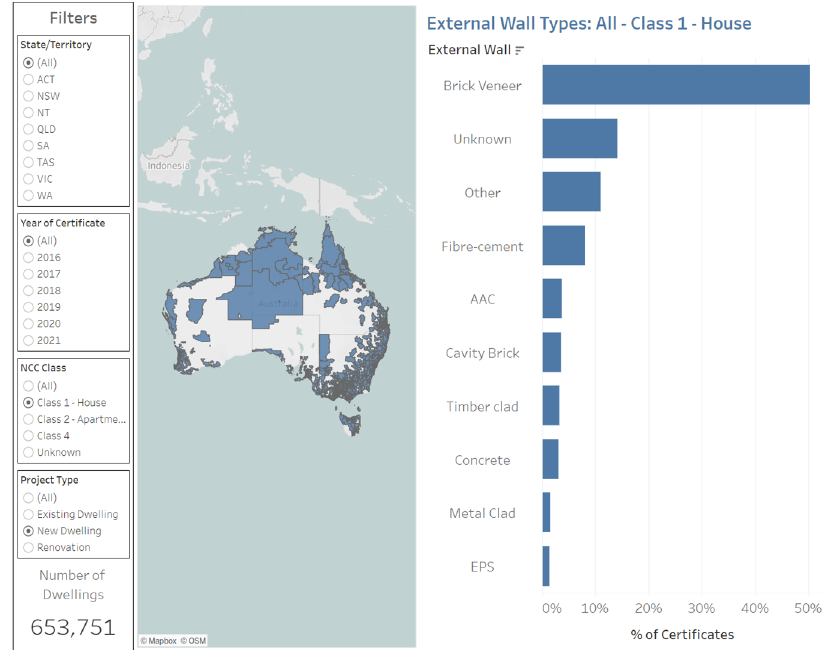
Figure 4. Types of external walls for Australia residential class 1 house. Source: https://ahd.csiro.au/dashboards/construction/walls/ (accessed on 4 November 2021) [38].